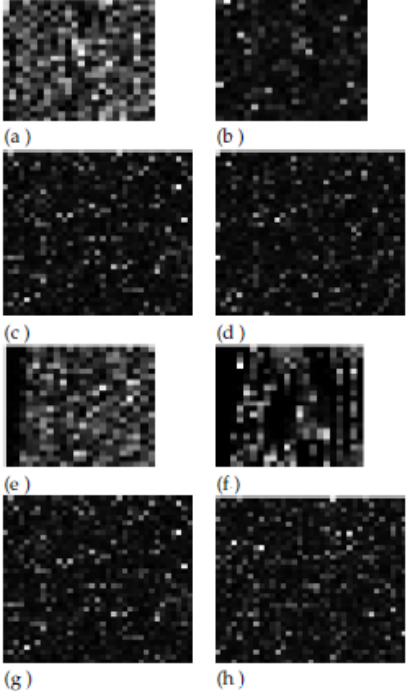
Figure 8. The comparisons between the activation maps for EfficientNet_ASPP for the combination between EfficientNet_ASPP and the textural features through the Concat+KPCA fusion scheme, respectively: ( a , b , e , f ) the maps for EfficientNet_ASPP combined with the textural features for HCC ( a , e ), respectively, PAR ( b , f ); ( c , d , g , h ) the maps achieved in the case of EfficientNet_ASPP for HCC ( c , g ), respectively, for PAR ( d , h ); ( a – d ) stand for GE7; ( e – h ) stand for GE9.